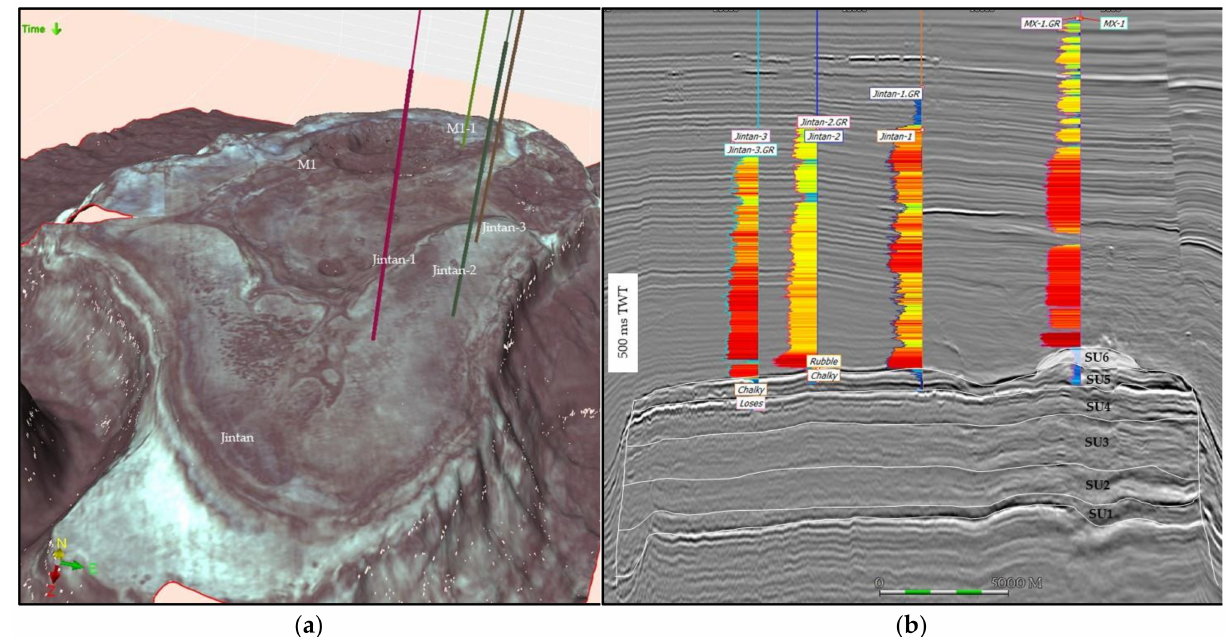
Figure 2. ( a ) 3D inline section showing Jintan and M1 fields and Jintan-1 and Jintan-2 wells. Annotated are the seismic units (SU1 to SU6) as interpreted by [12] ( b ) 3D image of the Mega Platform structure extracted from a coherency cube displaying the Jintan and M1 fields.